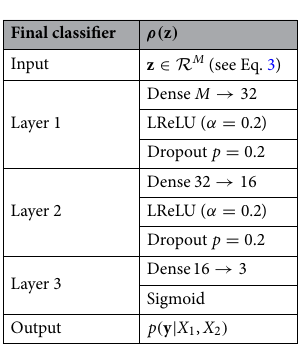
Table 7. Architecture of the final classifier ρ . M denotes the output dimension of the feature extraction modules, φ 1 , φ 2